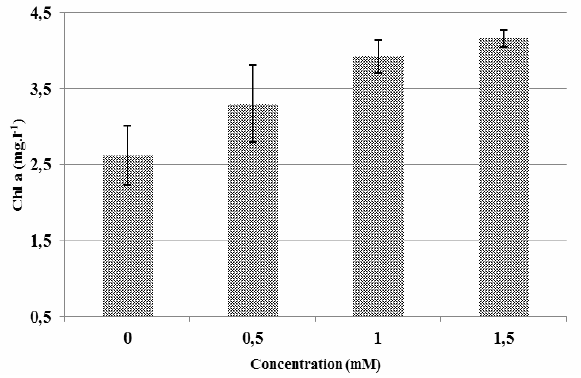
Fig. 3. Effect of different concentrations of SA on chlorophyll b content